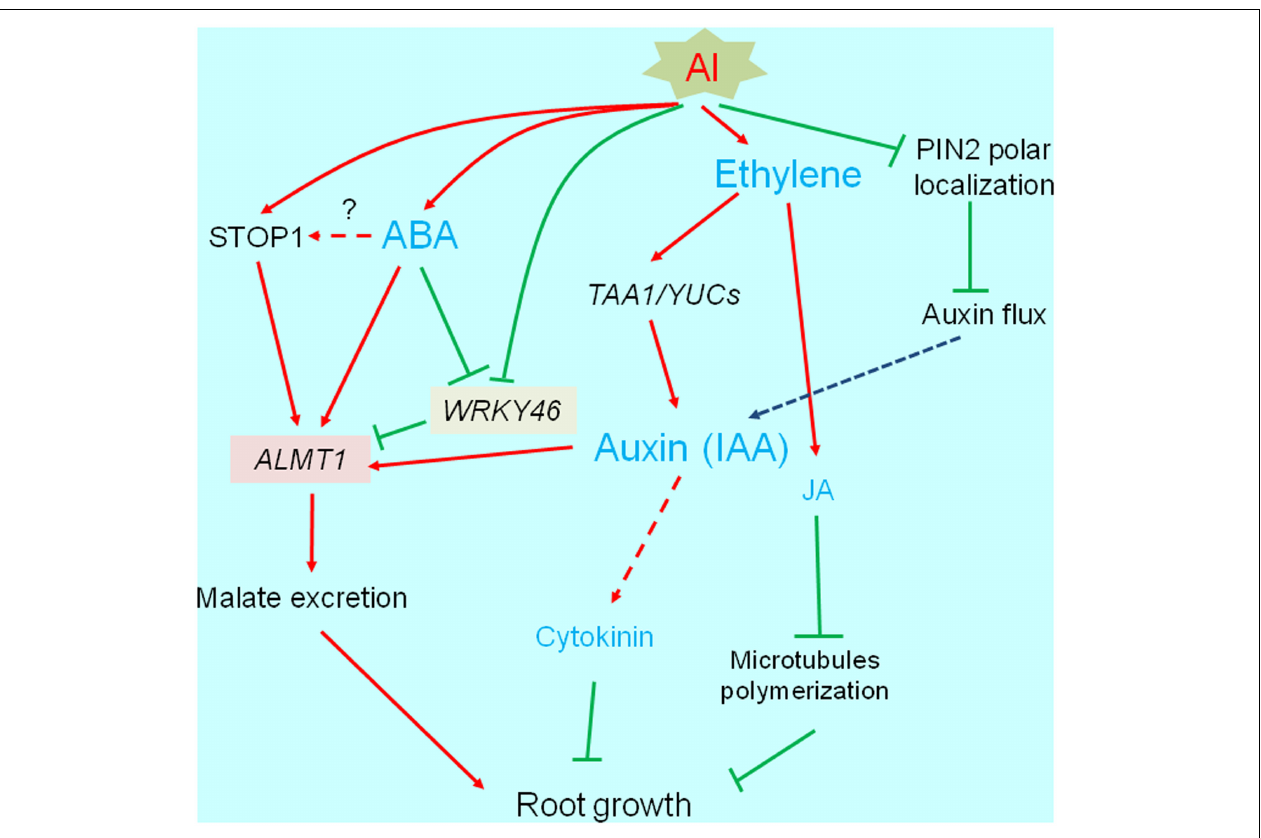
FIGURE 3 | Transcriptional regulation of phytohormone responsive root growth under Al stress. Al induces root growth inhibition, which is associated with increased ethylene synthesis followed by accumulation of auxin (IAA) and jasmonic acid (JA). These events occur within short-term range (3 h), which is associated with PIN-FORMED (PIN2). Finally, IAA and JA activated pathways are likely blocking root growth. IAA and abscisic acid activate ALUMINUM ACTIVATED MALATE TRANSPORTER1 ( ALMT1 ) expression, which may increase Al